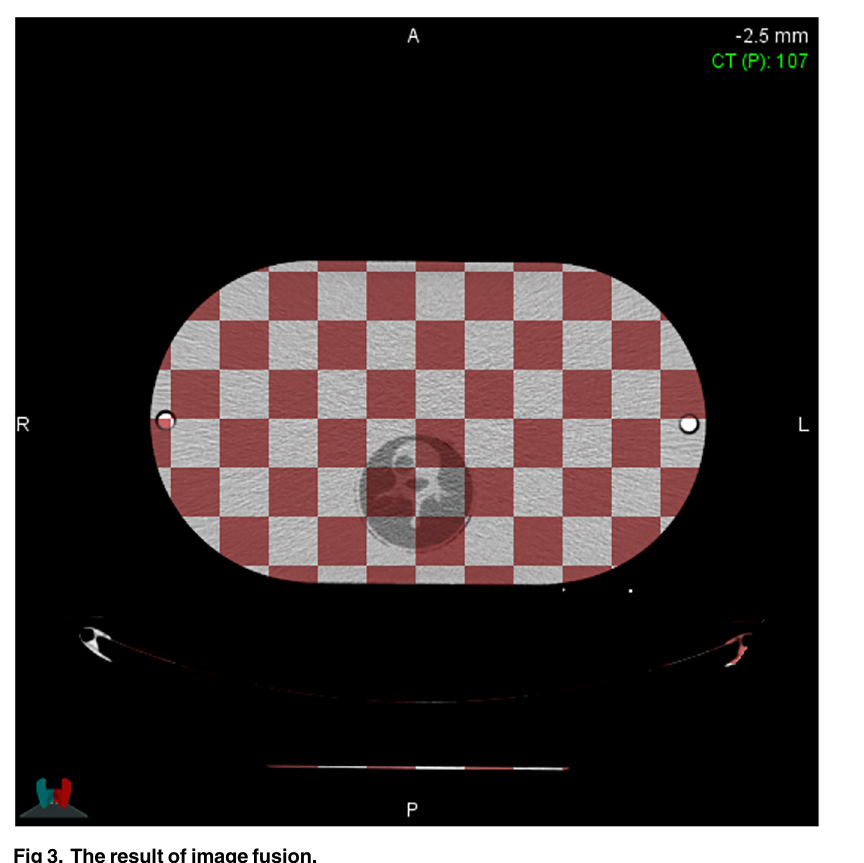
Fig 3. The result of image fusion.